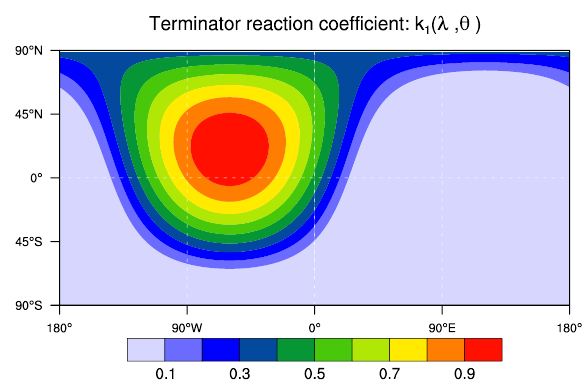
Figure 1. Contour plot of the terminator-“like” reaction coefficient k 1 (λ,θ) where λ and θ are longitude and latitude,